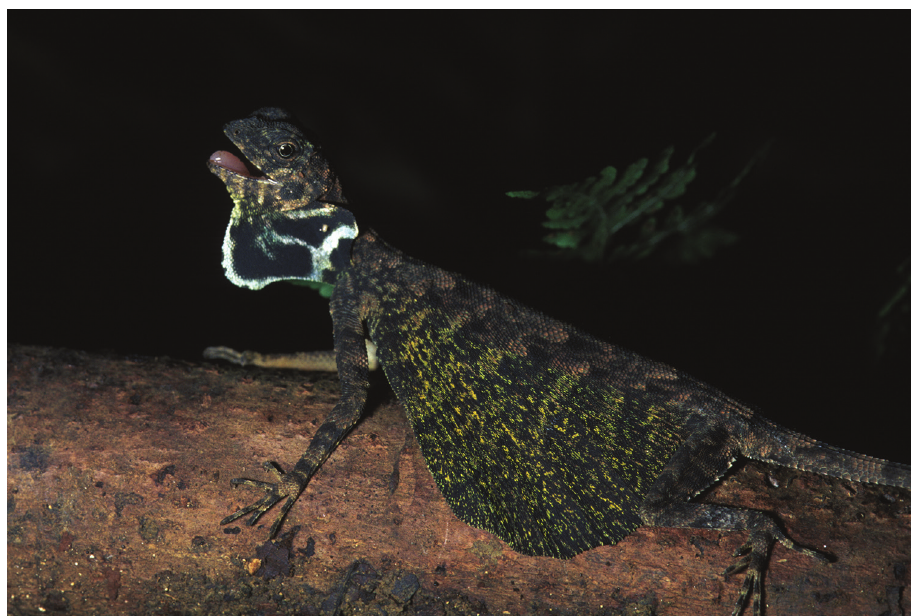
Figure 40. Draco bimaculatus is widely distributed throughout low elevation and coastal areas of north- east Mindanao. Photo: RMB (female from the Municipality of Bilar, Bohol Province, Bohol Island (speci- men deposited in